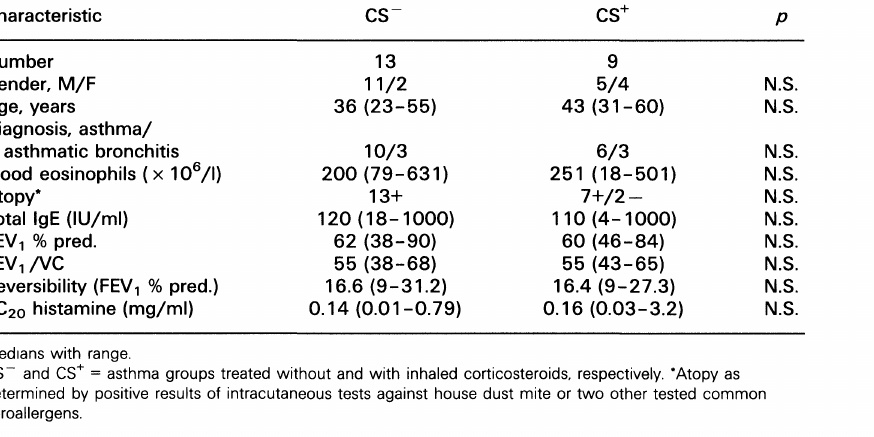
Table 2. Lung function parameters at the last visit just before bronchoscopy, according to treatment group